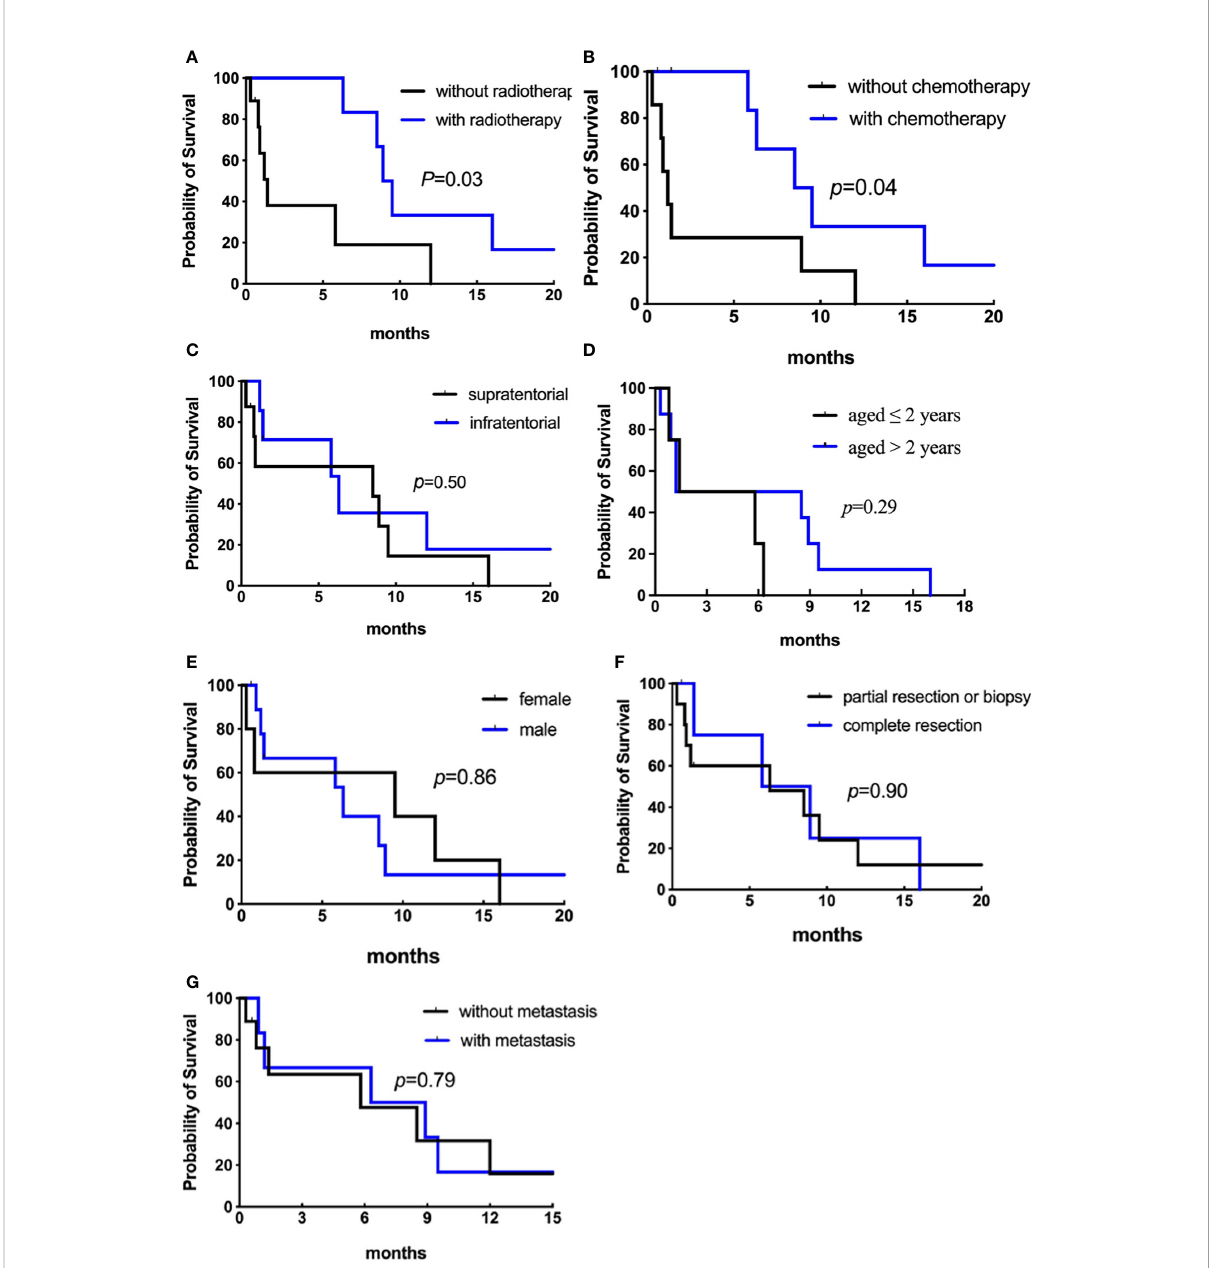
FIGURE 8 Analyses of overall survival (Kaplan – Meier method) according to (A) radiotherapy ( p = 0.03); (B) chemotherapy ( p = 0.04); (C) primary tumor location ( p = 0.50); (D) age at diagnosis ( p = 0.29). Figure 8.2 Analyses of overall survival (Kaplan – Meier method) according to (E) gender ( p = 0.86); (F) surgical resection ( p = 0.90); (G) metastatic status ( p =